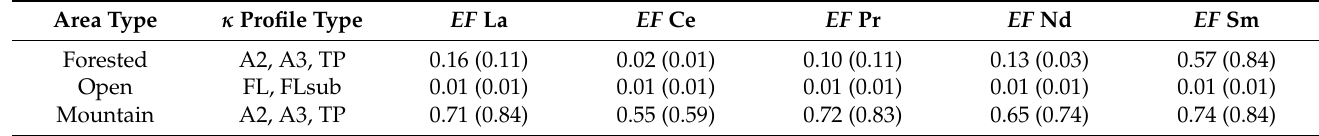
Table 6. Results of Kruskal–Wallis H test and median test in brackets. p -values for test with a hypothesis that all median EF values of different types of soil profile are equal versus hypothesis that there is at least one median that differs from the rest. Area